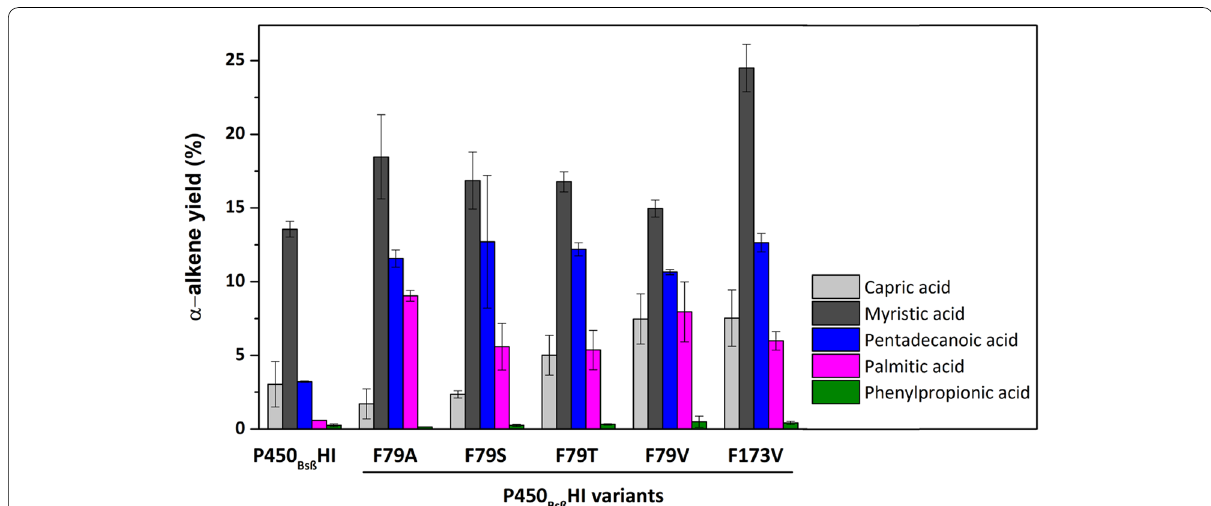
Fig. 4 Decarboxylation performance of P450 Bsβ HI and its variants towards various organic acid. Capric acid, myristic acid, pentadecanoic acid, palmitic acid, and phenylpropionic acid were used as substrate. All of the α-alkene products were qualitatively determined by contrasting with standard sample, and quantified by external standard method. Every bio-catalytic system contained 10 µM P450 Bsβ HI enzyme (or its variants), 500 µM corresponding fatty acid substrate (from a 100 mM stock solution in ethanol) and 1 mM H 2 O 2 in a final volume of 1 mL of 100 mM potassium phosphate buffer (pH 8.0). Results shown are mean SD of duplicated = ±